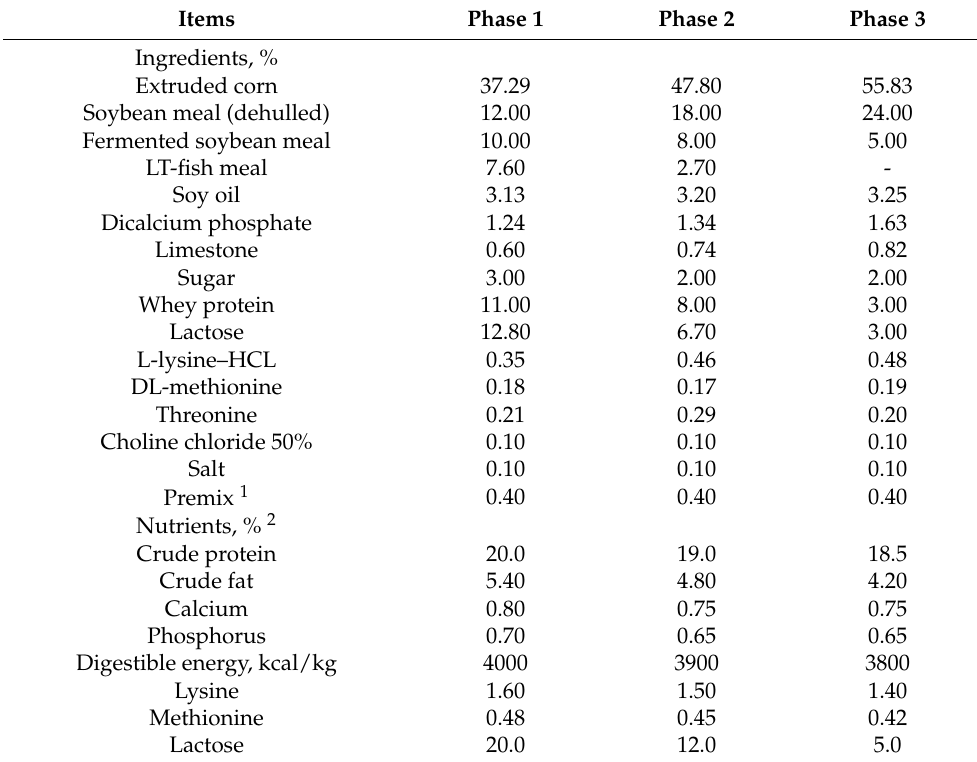
Table 1. Composition of basal weaning pig diets (as